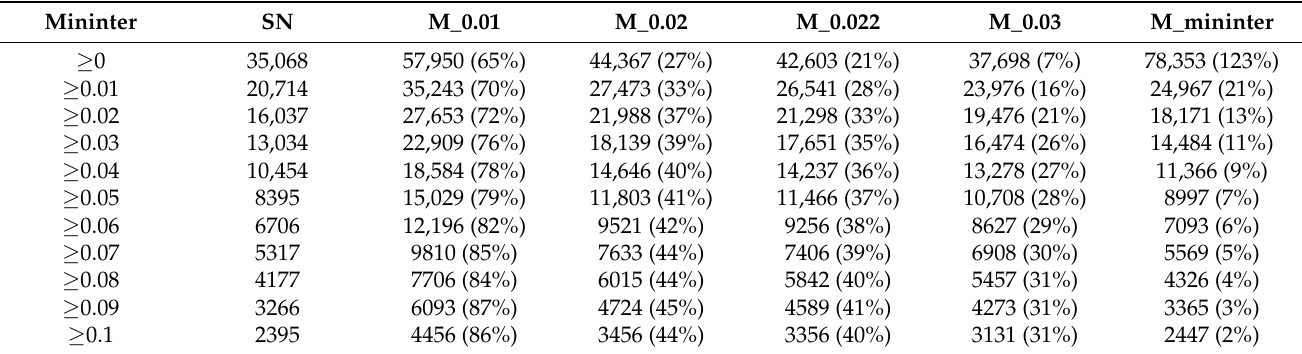
Table 1. The result of clustering analysis based on different thresholds.